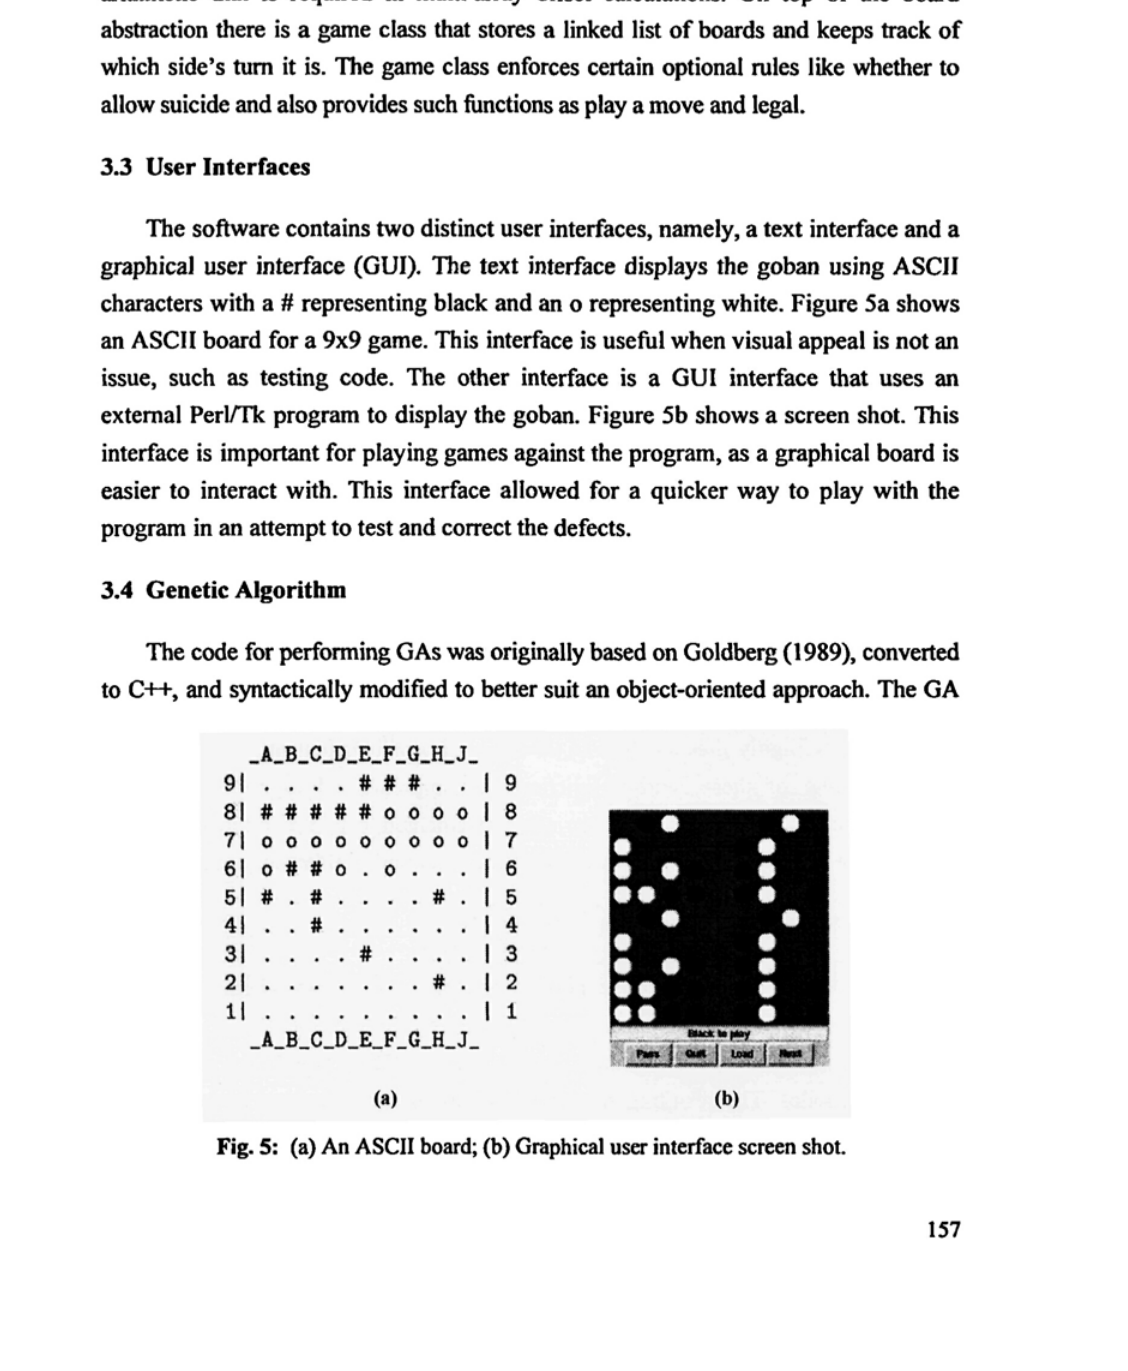
Fig. 5: (a) An ASCII board; (b) Graphical user interface screen